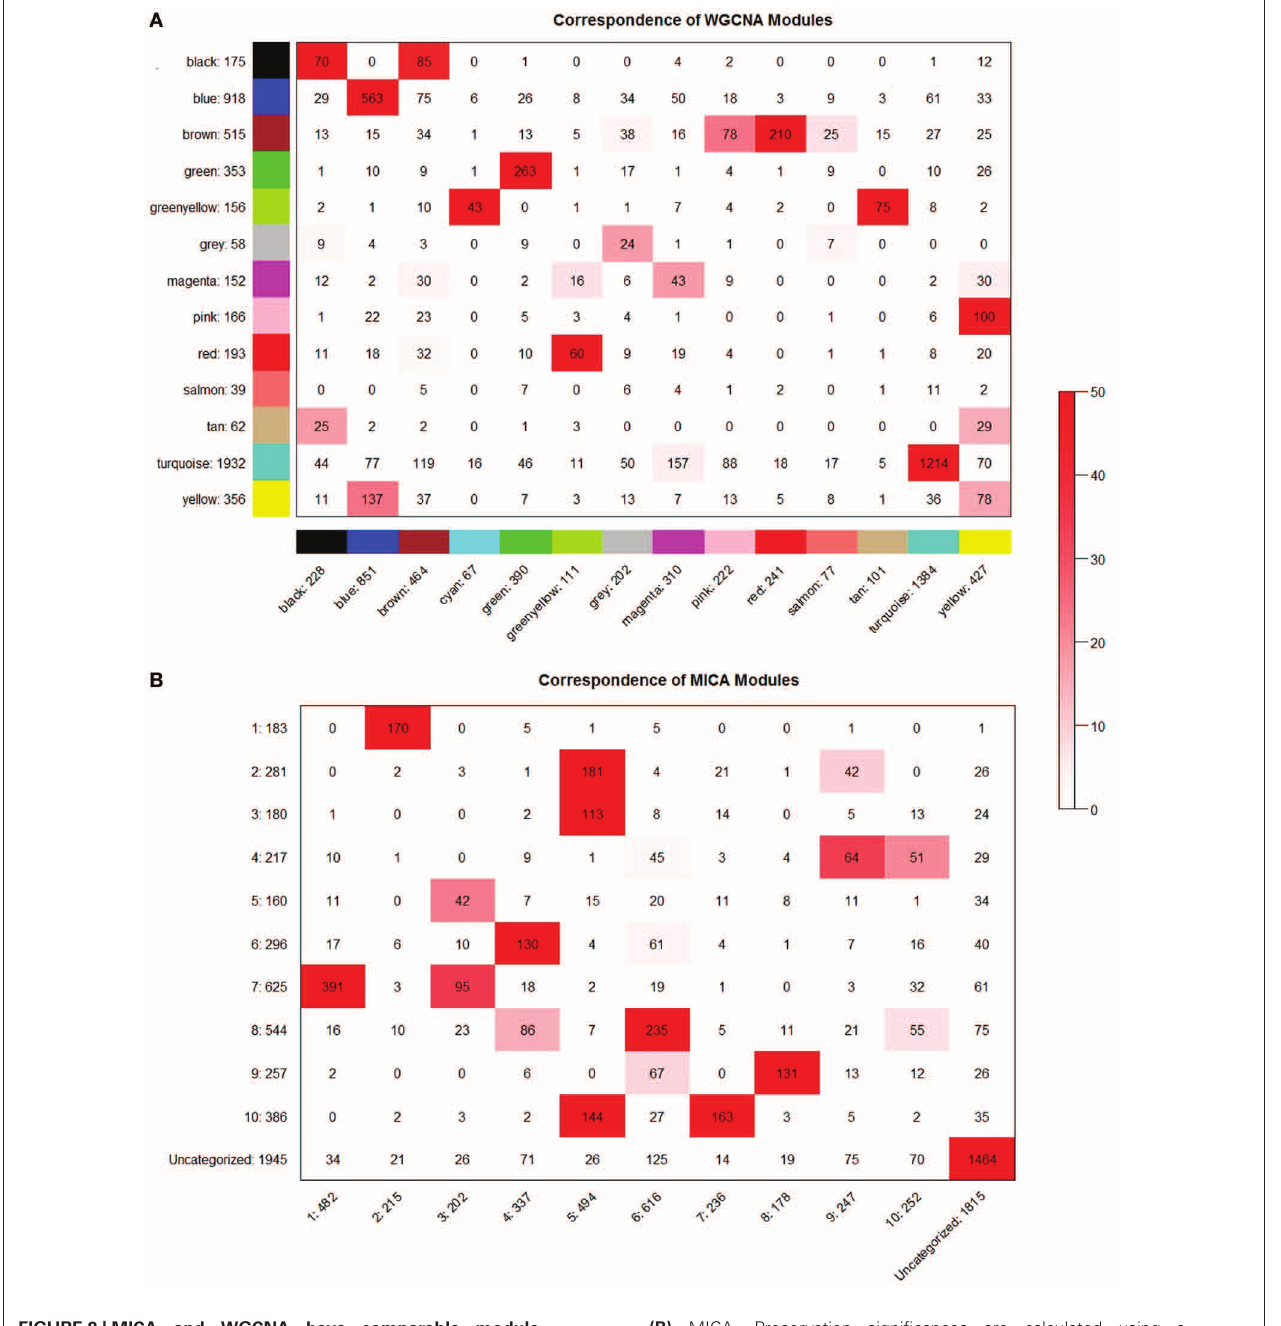
(B) MICA. Preservation significances are calculated using a Fisher’s exact test and are represented by the depth of the red color as